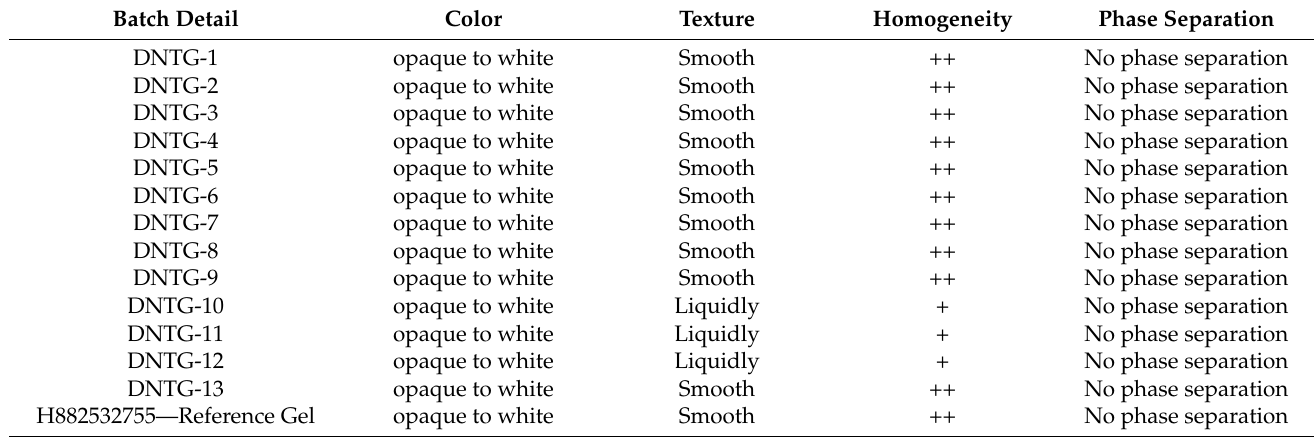
Figure 4. Viscosity rheological data comparison between DNTG-1 to DNTG-9, DNTG-13 (niosomal gel), and H882532755 (reference gel). Table 7. Physicochemical properties of desoximetasone niosomal topical